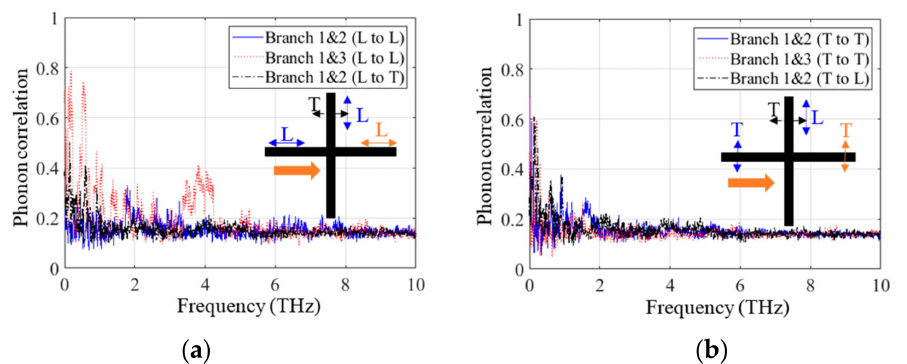
Figure 11. Collective power spectra of velocity cross-correlations of ( a ) longitudinal and ( b ) transverse vibrations of branch 1 with those of branches 2 and 3 for cross-junction